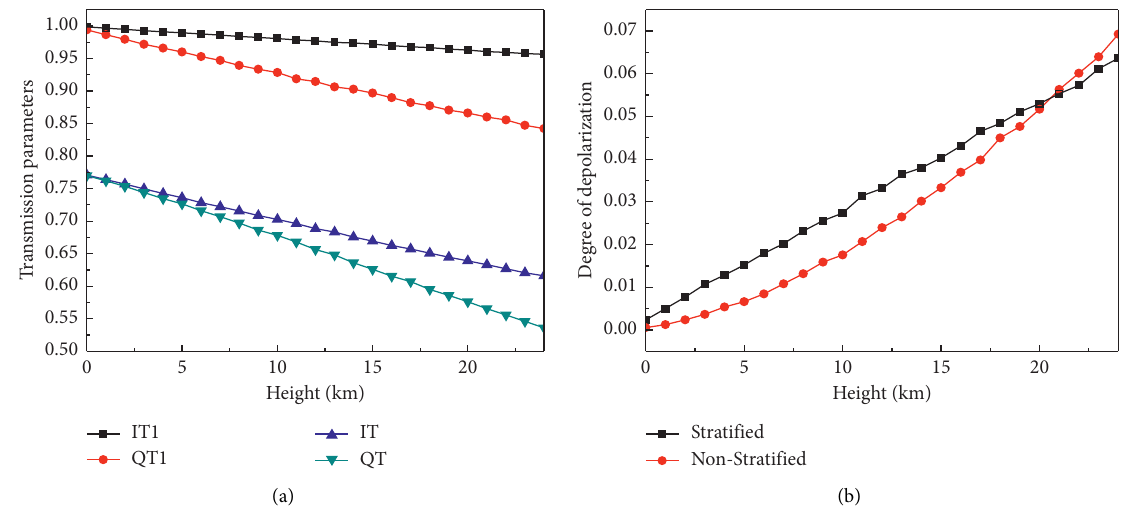
Figure 9: Variation of polarization parameters (stratified and nonstratified) with height ( b � 0.4 μ